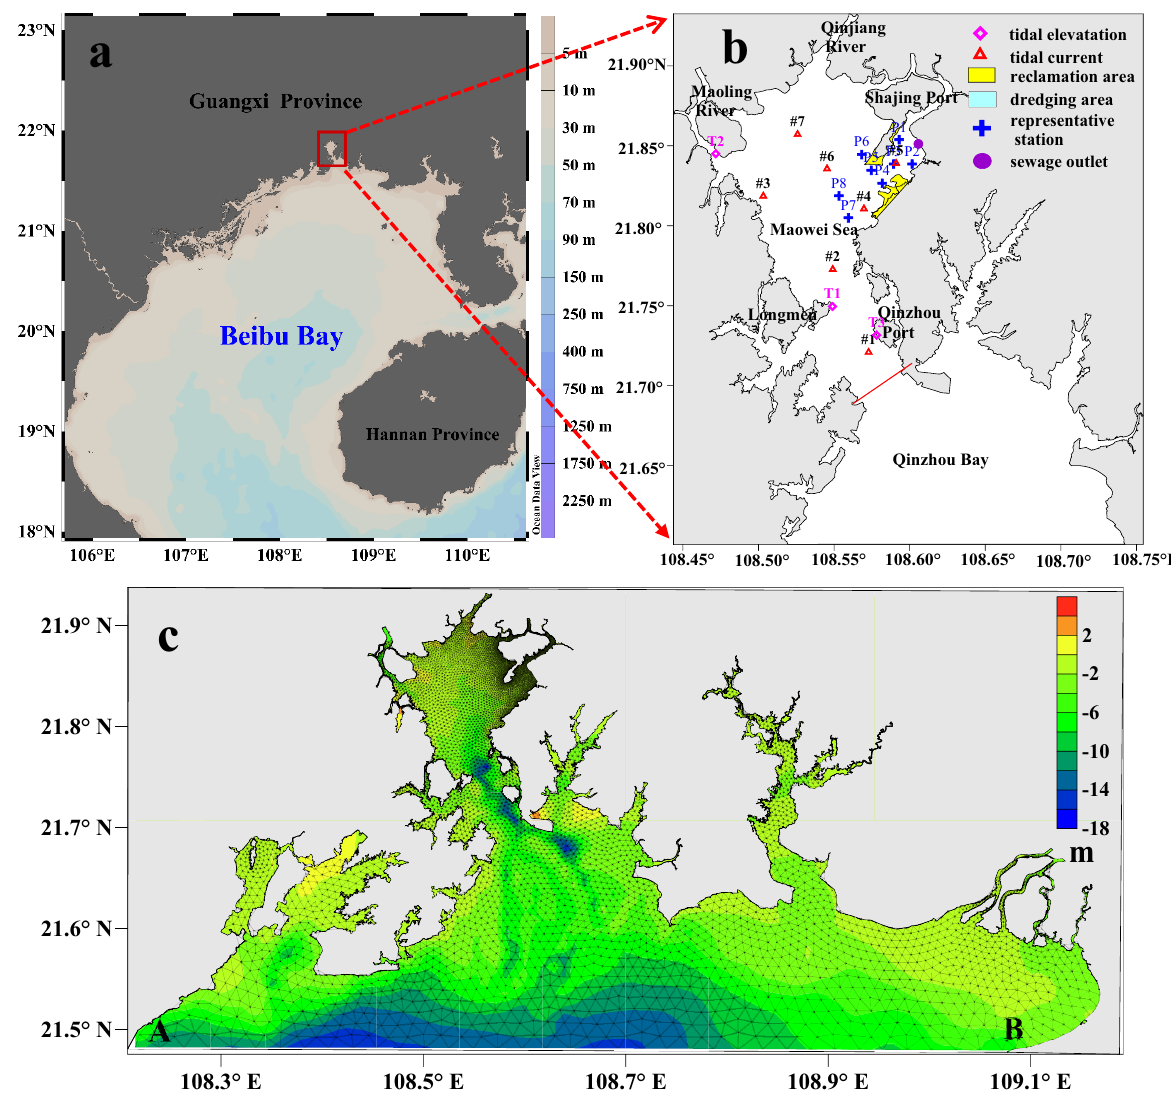
Figure 1. Map showing the location (a) , the investigated stations (b) and the triangular mesh (c) in the Maowei Sea. These figures were plotted using the Ocean Data View (Schlitzer, R., https:// odv. awi. de, 2018) (a) and Surfer10 Software (https:// www. golde nsoft ware. com/ produ cts/ surfer) (b,c)